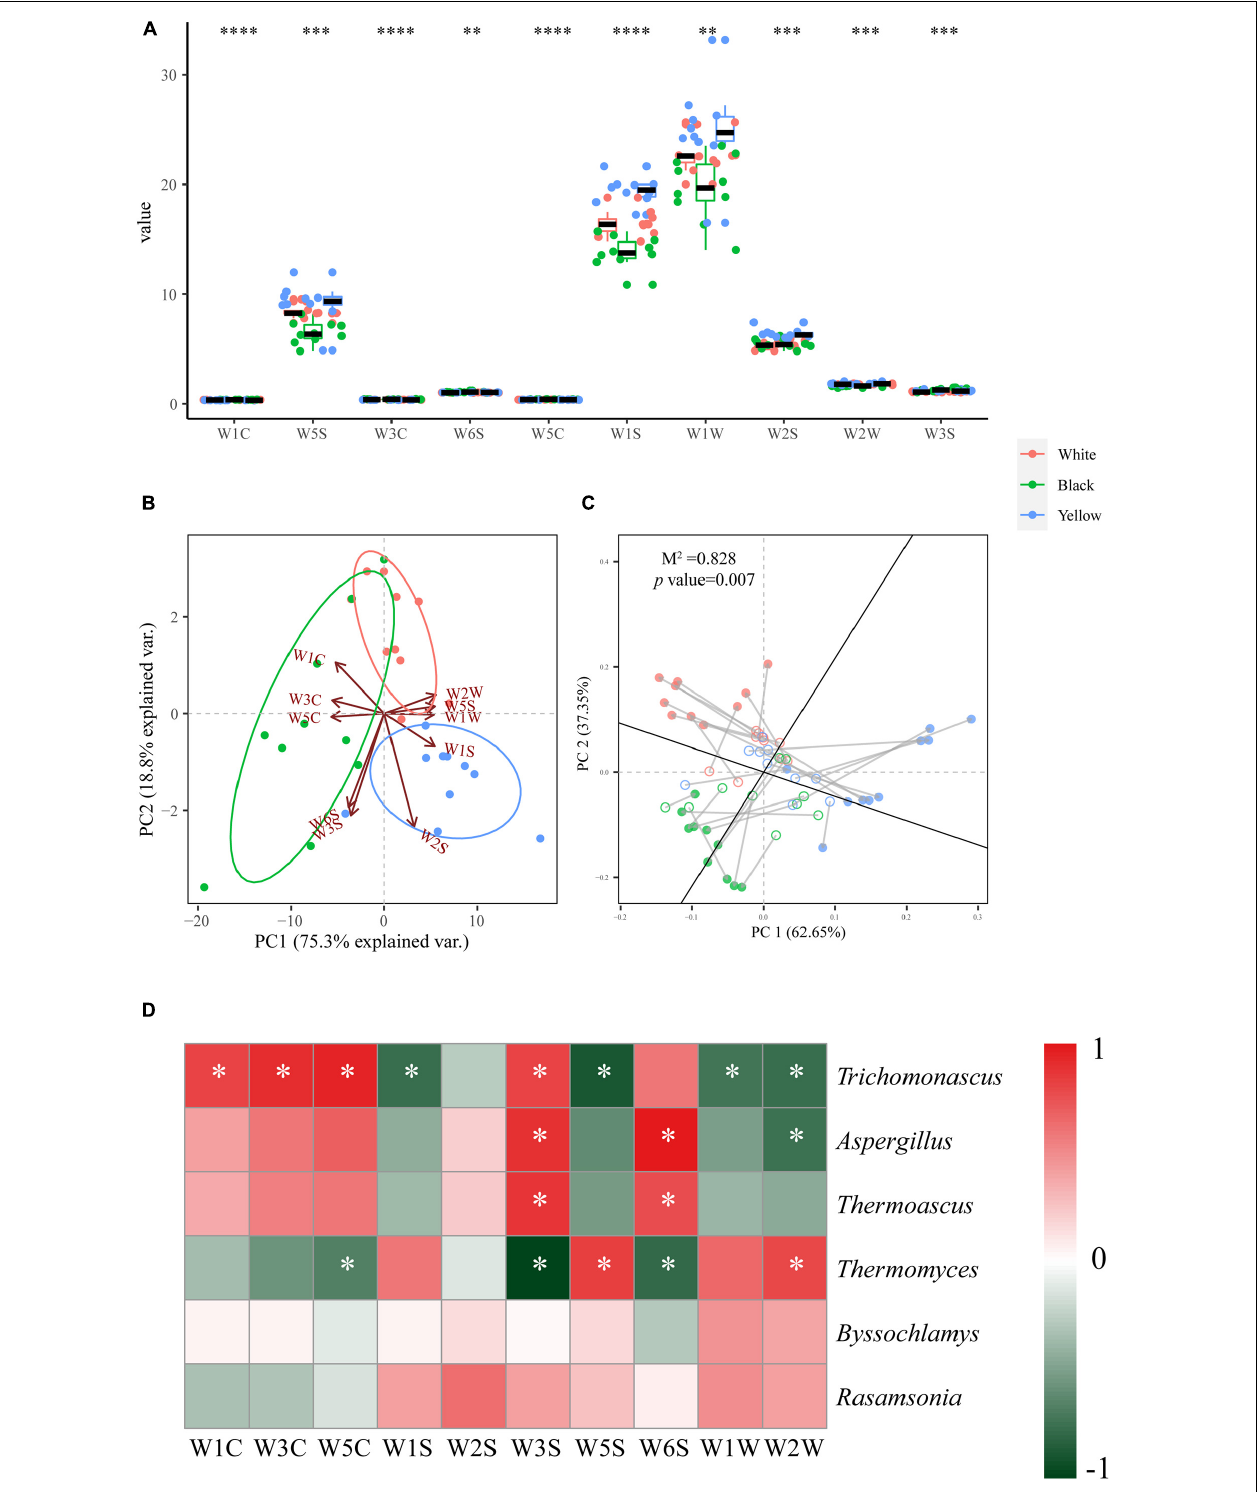
FIGURE 6 | Box plot for aroma profiles of the three types of HTD samples (A) . Significant difference is represented by ∗∗∗∗ ( p < 0.0001), ∗∗∗ (0.0001 ≤ p < 0.001), and ∗∗ (0.001 ≤ p < 0.01), respectively. PCA biplot based on the aroma profiles of HTD samples (B) . Procrustes analysis of the correlation between dominate fungal genera and aroma profiles ( M 2 = 0.828, p = 0.007, 999 permutations) (C) . Heatmap depicting the Spearman’s rank correlation between dominant fungal genera and E-nose sensors. Significant difference is represented by * ( p < 0.05) (D) .